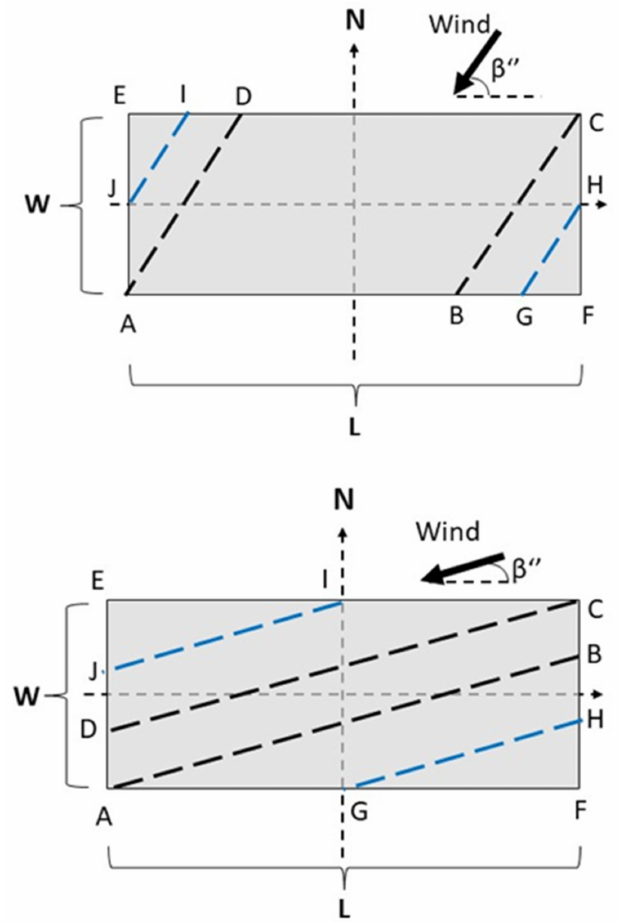
Figure 6. Wind path approximation. P is represented by the dashed black lines, while Pa is repre- sented by the blue dashed lines. Top : the wind vector enters and exits through L. Bottom : the wind vector enters and exits through